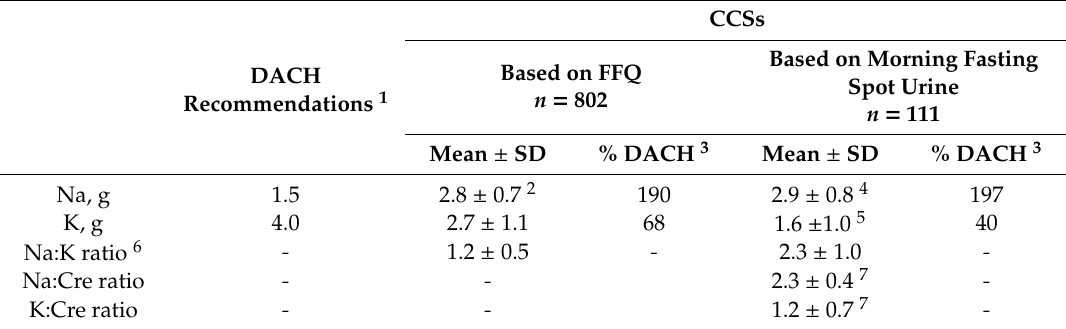
Table 3. Sodium (Na) and potassium (K) intake of adult childhood cancer survivors (CCSs).